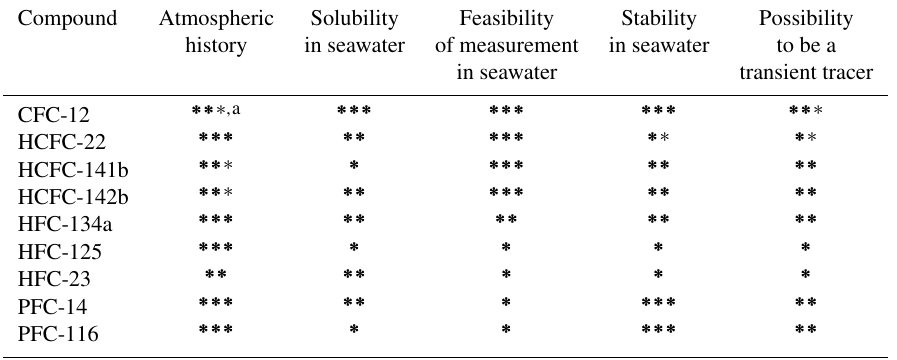
Table 4. Evaluating the possibilities of selected HCFCs, HFCs, and PFCs as transient tracers in the ocean in terms of four aspects. Compound Atmospheric Solubility Feasibility Stability Possibility history in seawater of measurement in seawater to be a in seawater transient tracer CFC-12 ∗∗ ∗ , a ∗∗∗ ∗∗∗ ∗∗∗ ∗∗ ∗ HCFC-22 ∗∗∗ ∗∗ ∗∗∗ ∗ ∗ ∗ ∗ HCFC-141b ∗∗ ∗ ∗ ∗∗∗ ∗∗ ∗∗ HCFC-142b ∗∗ ∗ ∗∗ HFC-134a ∗∗∗ ∗∗ ∗∗ HFC-125 ∗∗∗ HFC-23 ∗∗ ∗∗ PFC-14 ∗∗∗